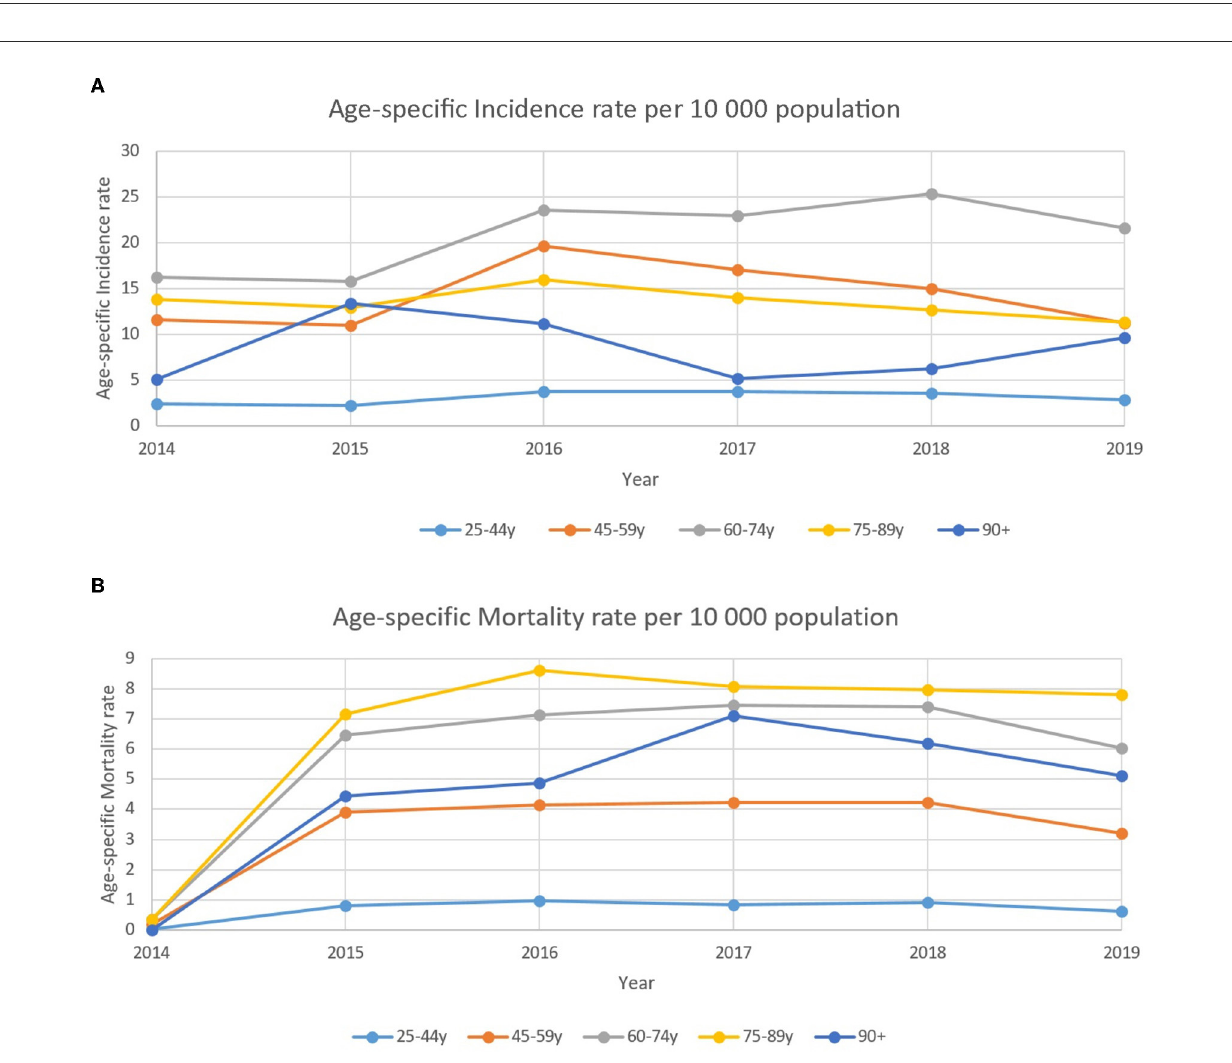
FIGURE4 (A) Age-specific incidence rate of patients with breast cancer per 10,000 population between 2014–2019. (B) Age-specific standardized mortality rate of patients with breast cancer per 10,000 population between